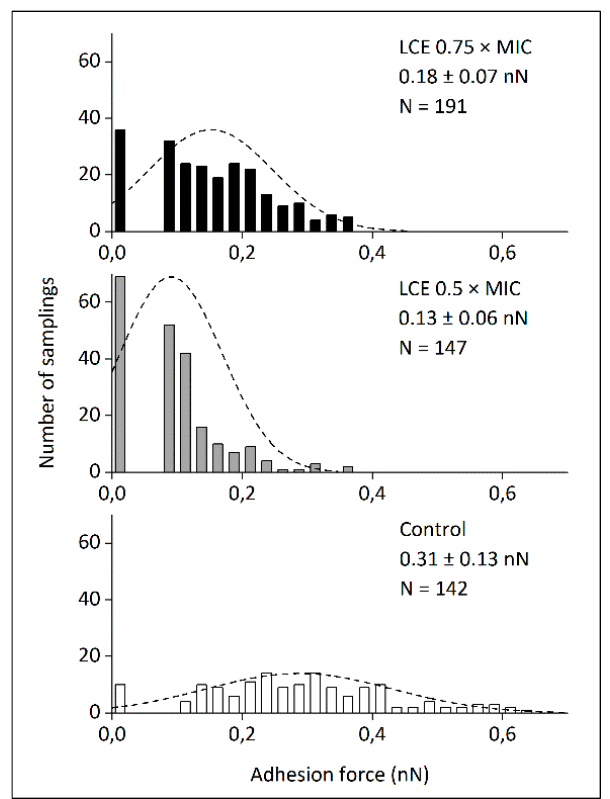
Figure 2. Changes of S. aureus 8325-4 adhesive properties after exposure to L. cardiaca L. extract (LCE) at 0.5 × MIC or 0.75 × MIC for 24 h, measured using atomic force microscopy (AFM). Statistical analysis was estimated with nonparametric Kruskal – Wallis one-way ANOVA test. The differences were significant in comparison to the control ( p < 0.001).